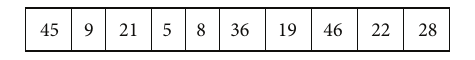
Figure 5: A chromosome that represents one feasible solution.